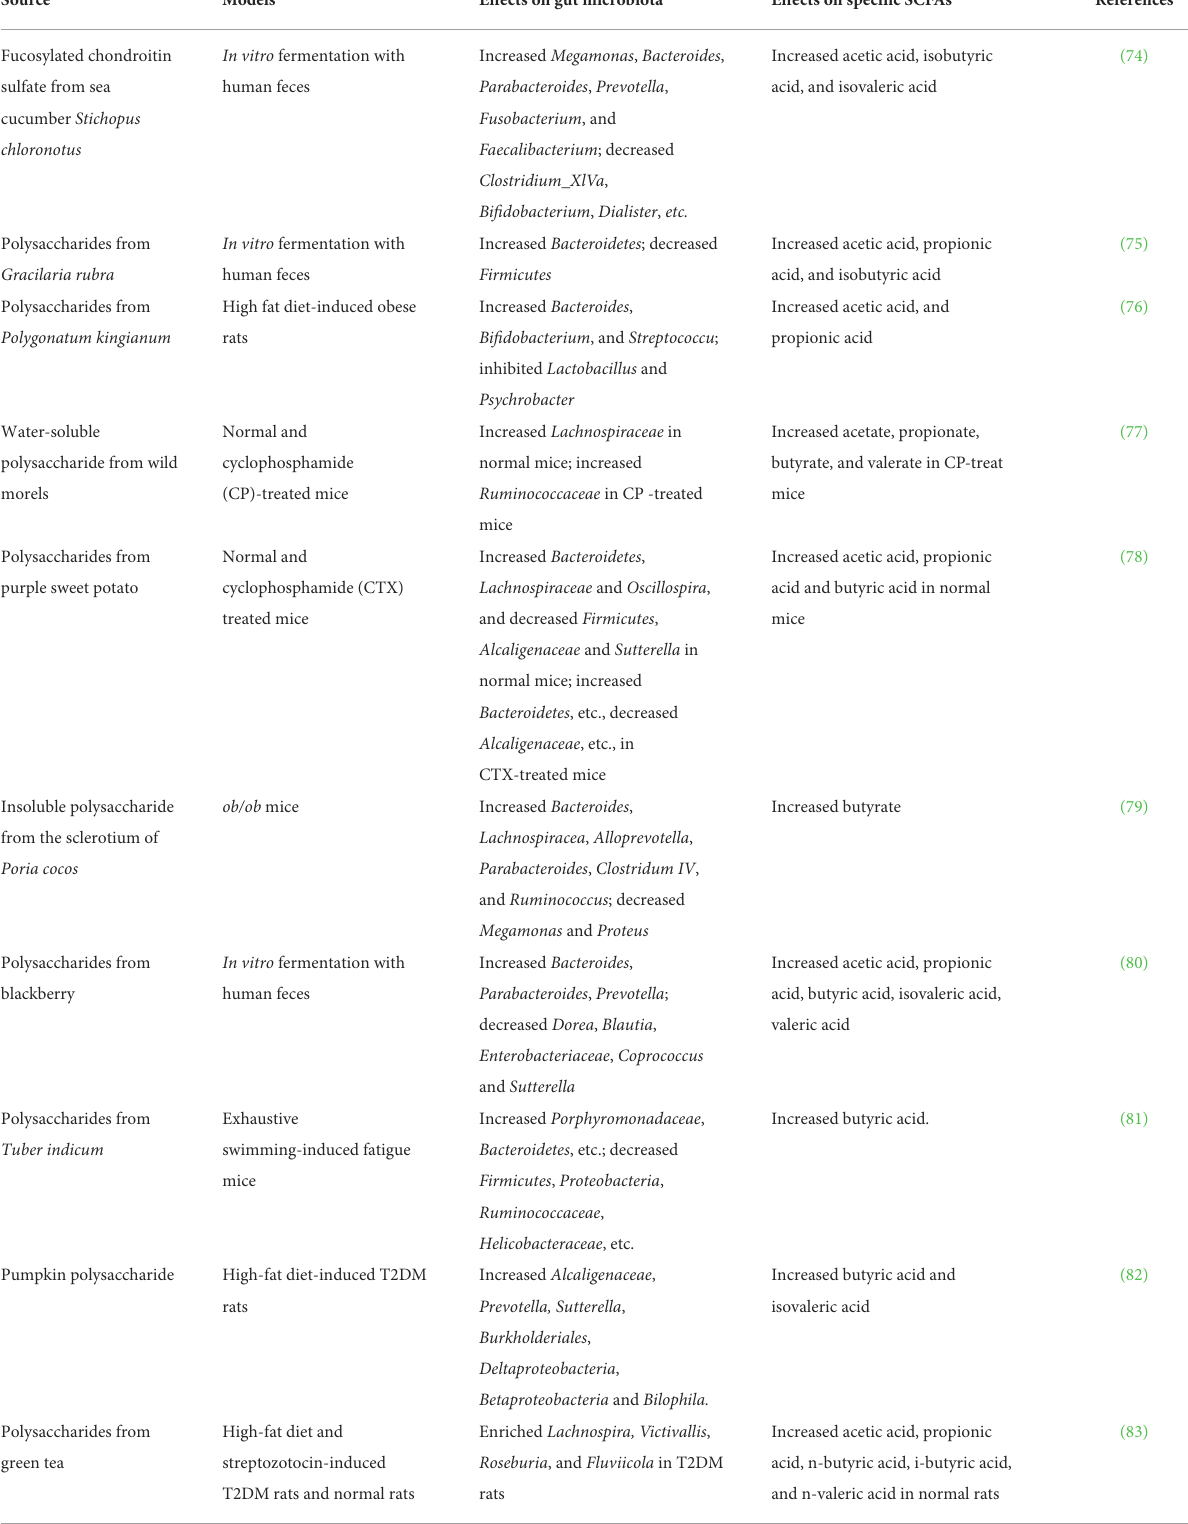
TABLE 2 Effects of dietary polysaccharides on